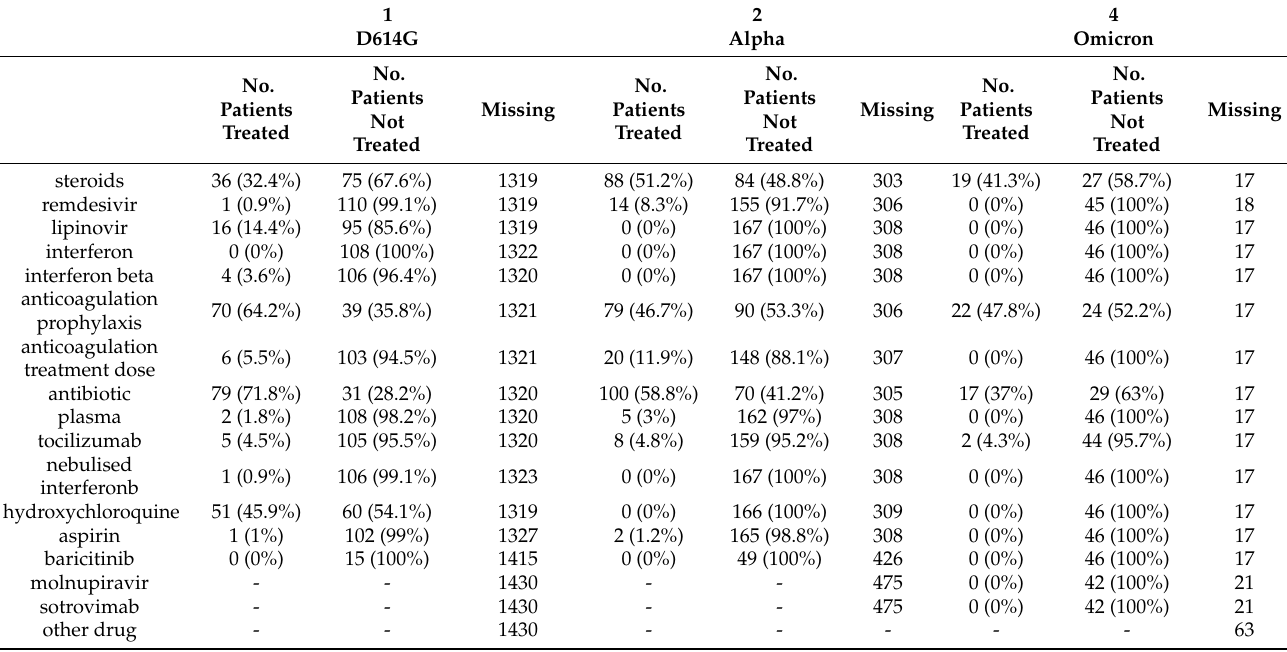
Table 3. Treatments for COVID-19.